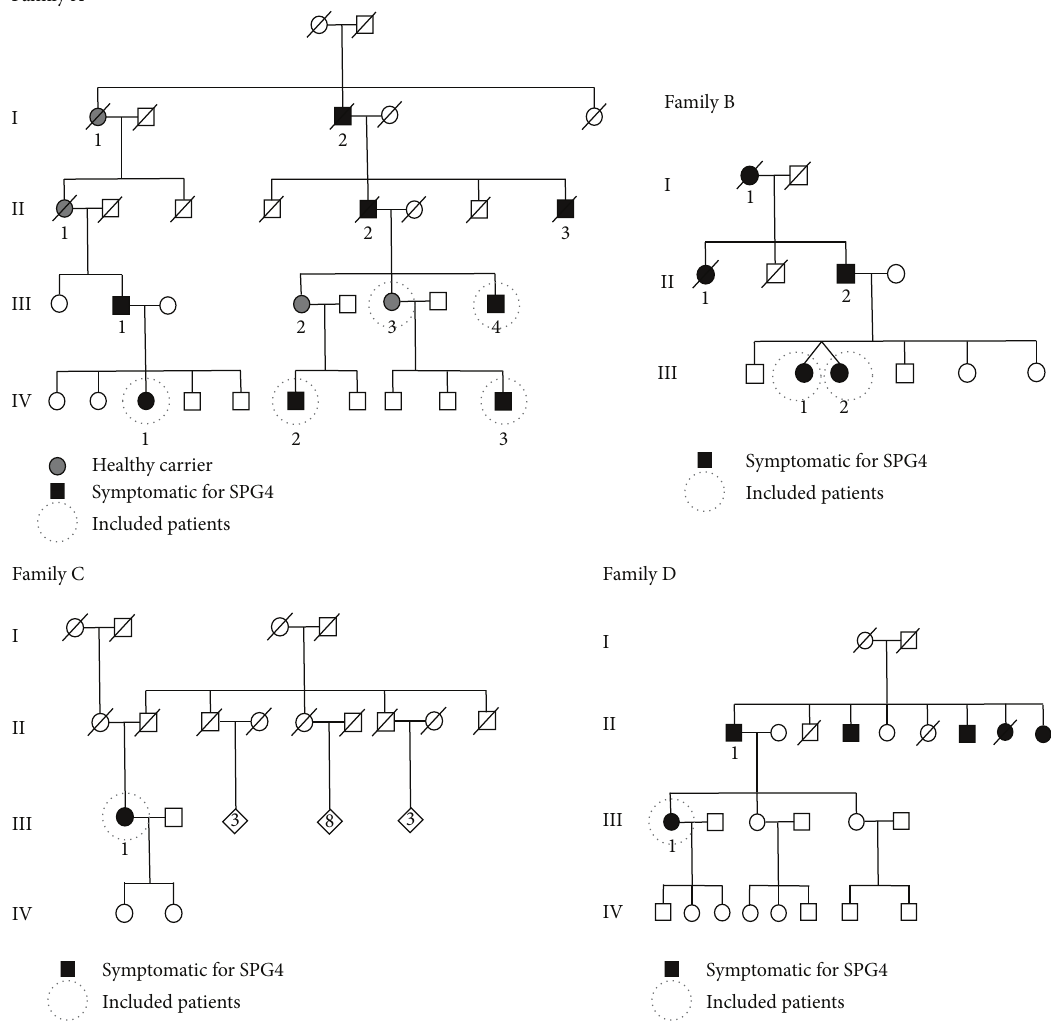
Figure 1: Pedigrees of the four